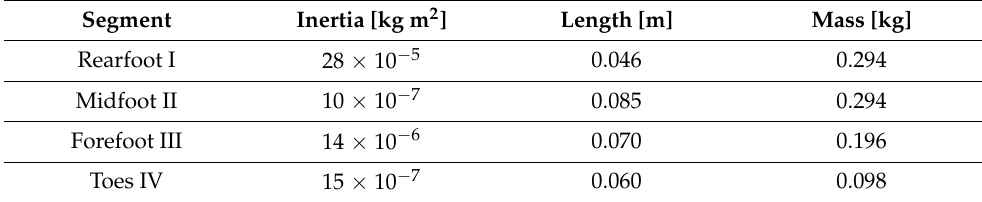
Table 1. Inertial and geometrical properties of foot segments